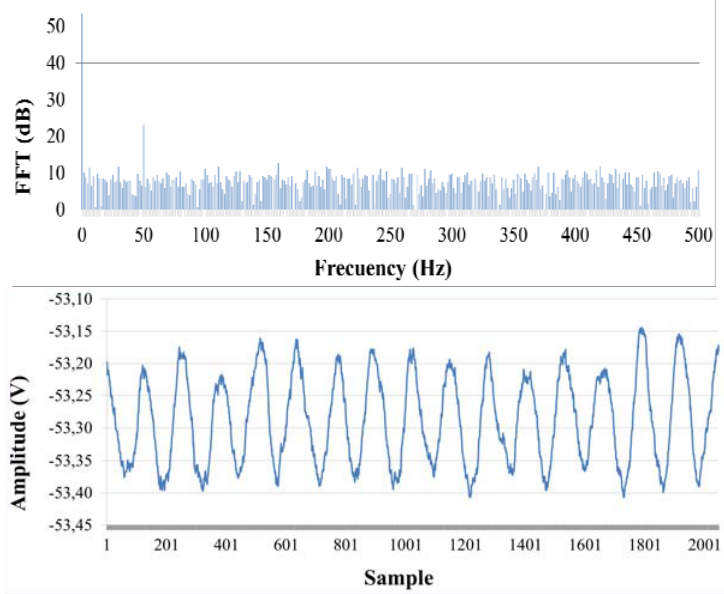
Figure 7. Optical signal received after amplification for I = 400 A ( Above ). DFT of the optical signal from 0 to 500 Hz ( Below